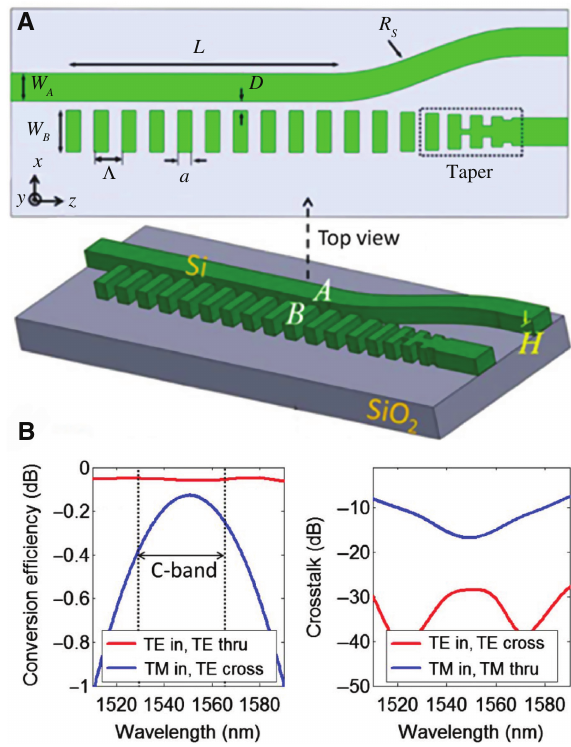
Figure 7: Theoretical study of a subwavelength structured PSR based on an asymmetric